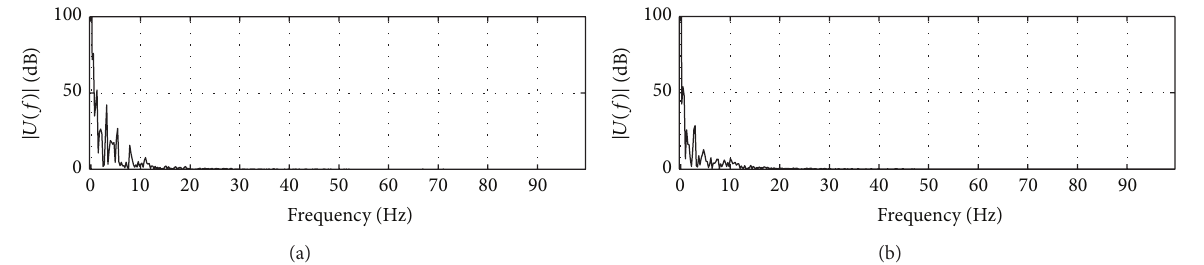
Figure 15: Execution frequency curves of the (a) SMTT and (b) TEC-SMTT commands.